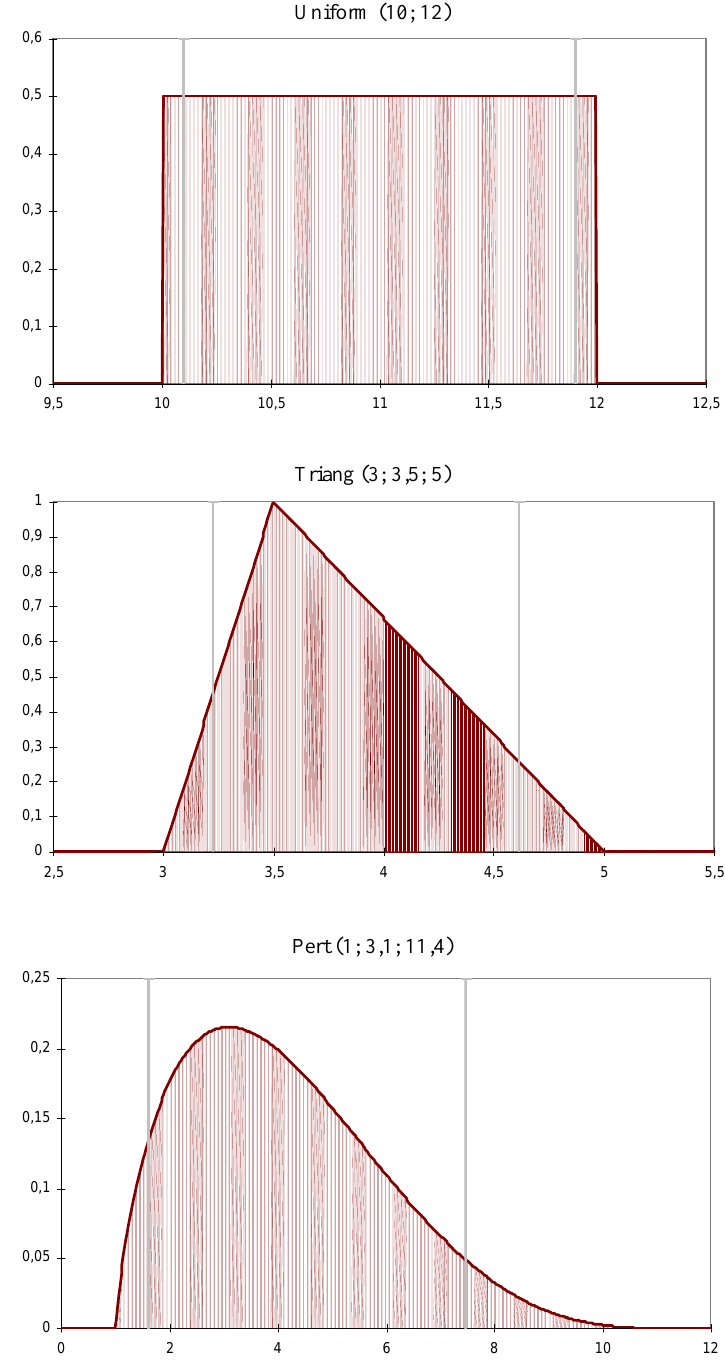
Fig 4. Selected distributions for cost